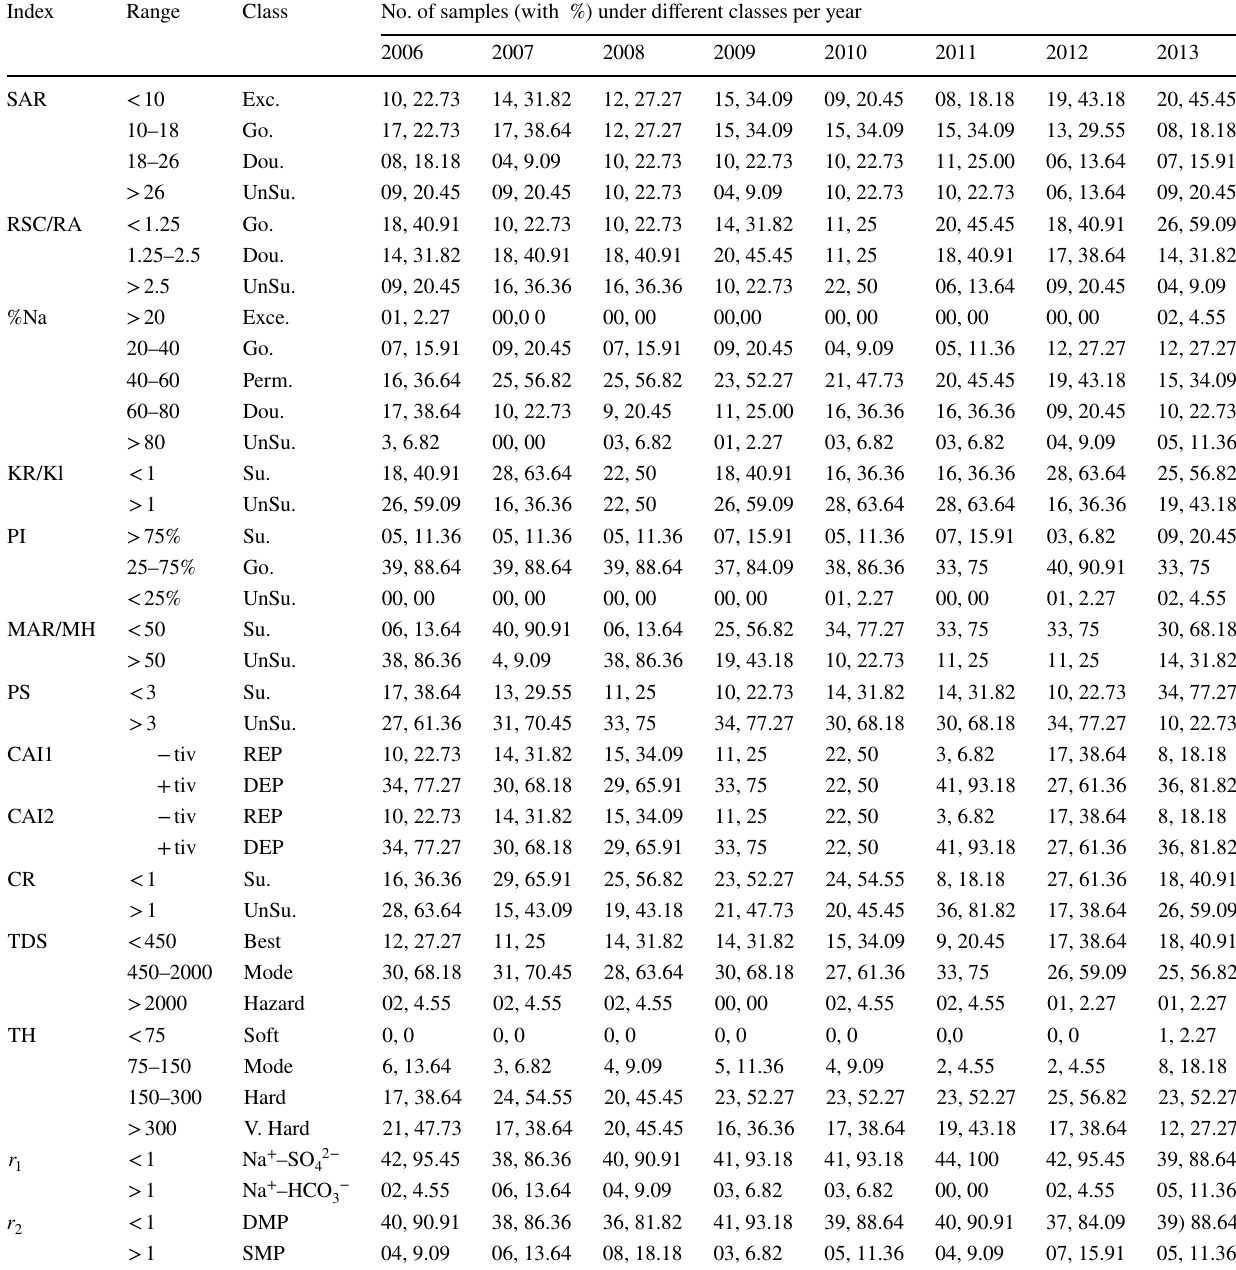
Table 5 Classification of fixed bore wells water during post-monsoon within the study area for irrigation based on %Na, SAR, MH, KR